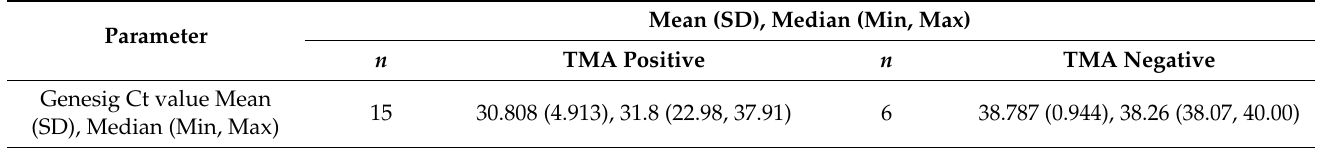
Table 4. Ct values of the Genesig real-time PCRs for samples concordantly positive by TMA and real-time PCR as well as positive by real-time PCR